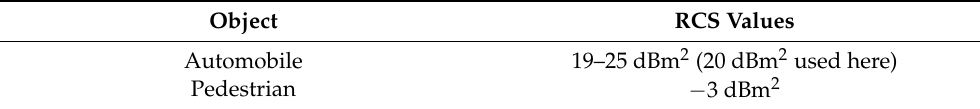
Table 2. Radar Cross Section values